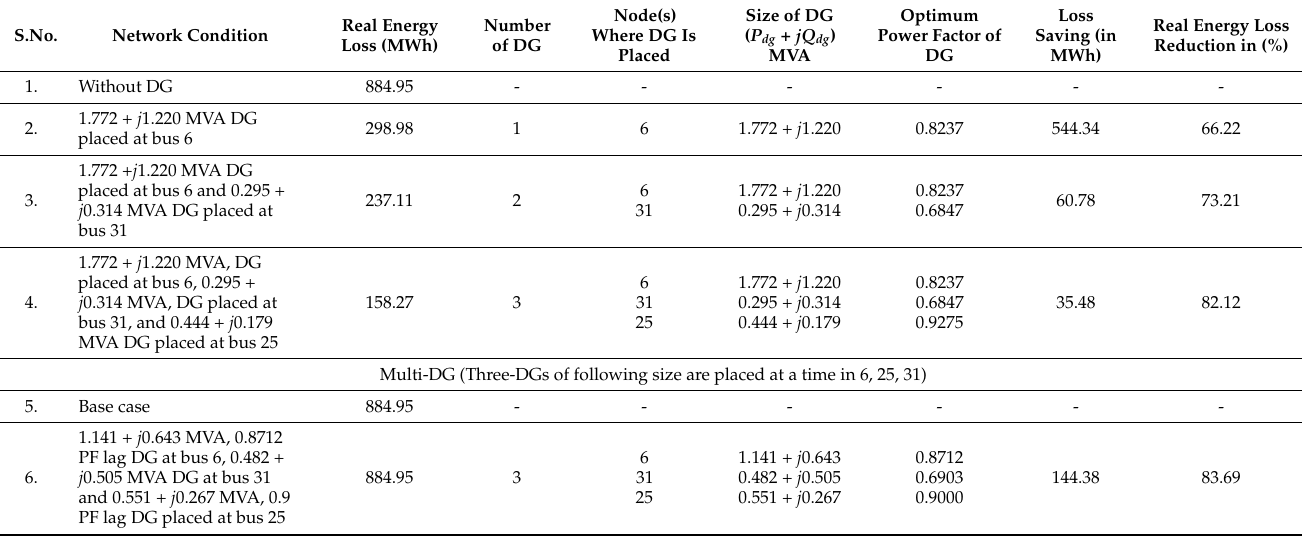
Table A3. Summary of simulation results for IEEE 33-bus